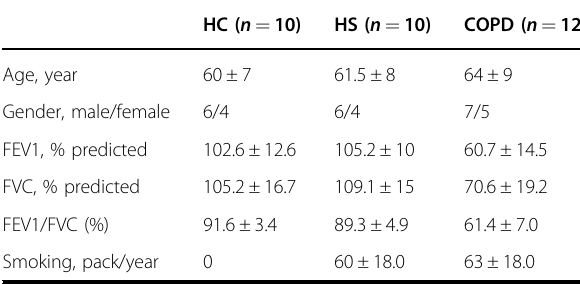
Table 1 Demographic characteristics of patients